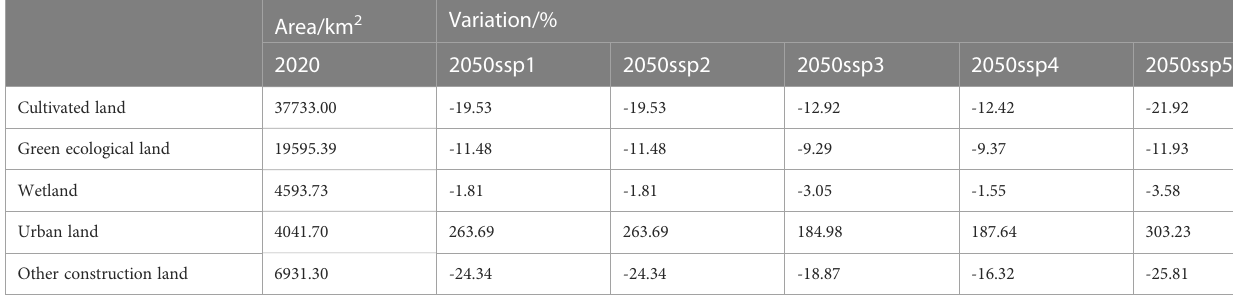
TABLE 4 Area change of land use types under different scenarios from 2020 to